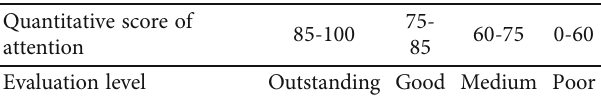
Table 2: Student classroom attention